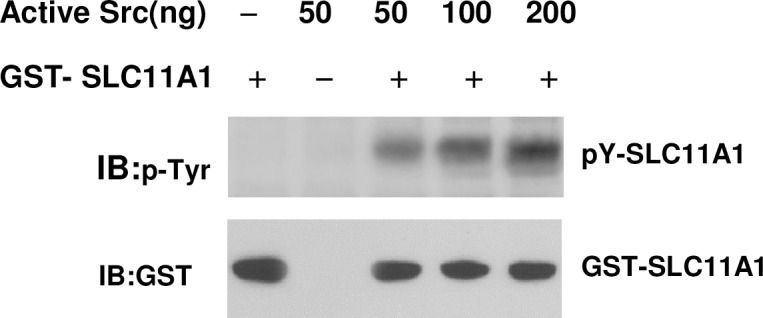
In vitro phosphorylation of SLC11A1 by c-Src.A fixed amount of GST-SLC11A1 (500ng, a.a.1-a.a.178) was incubated with increasing amounts (50-200ng) of purified Src, as indicated. Phosphorylation levels of protein were analyzed by immunoblotting with anti-phosphotyrosine antibodies (4G10) (top). The same blots were then reprobed with anti-GST antibodies for GST-SLC11A1 fusion protein as a loading control.